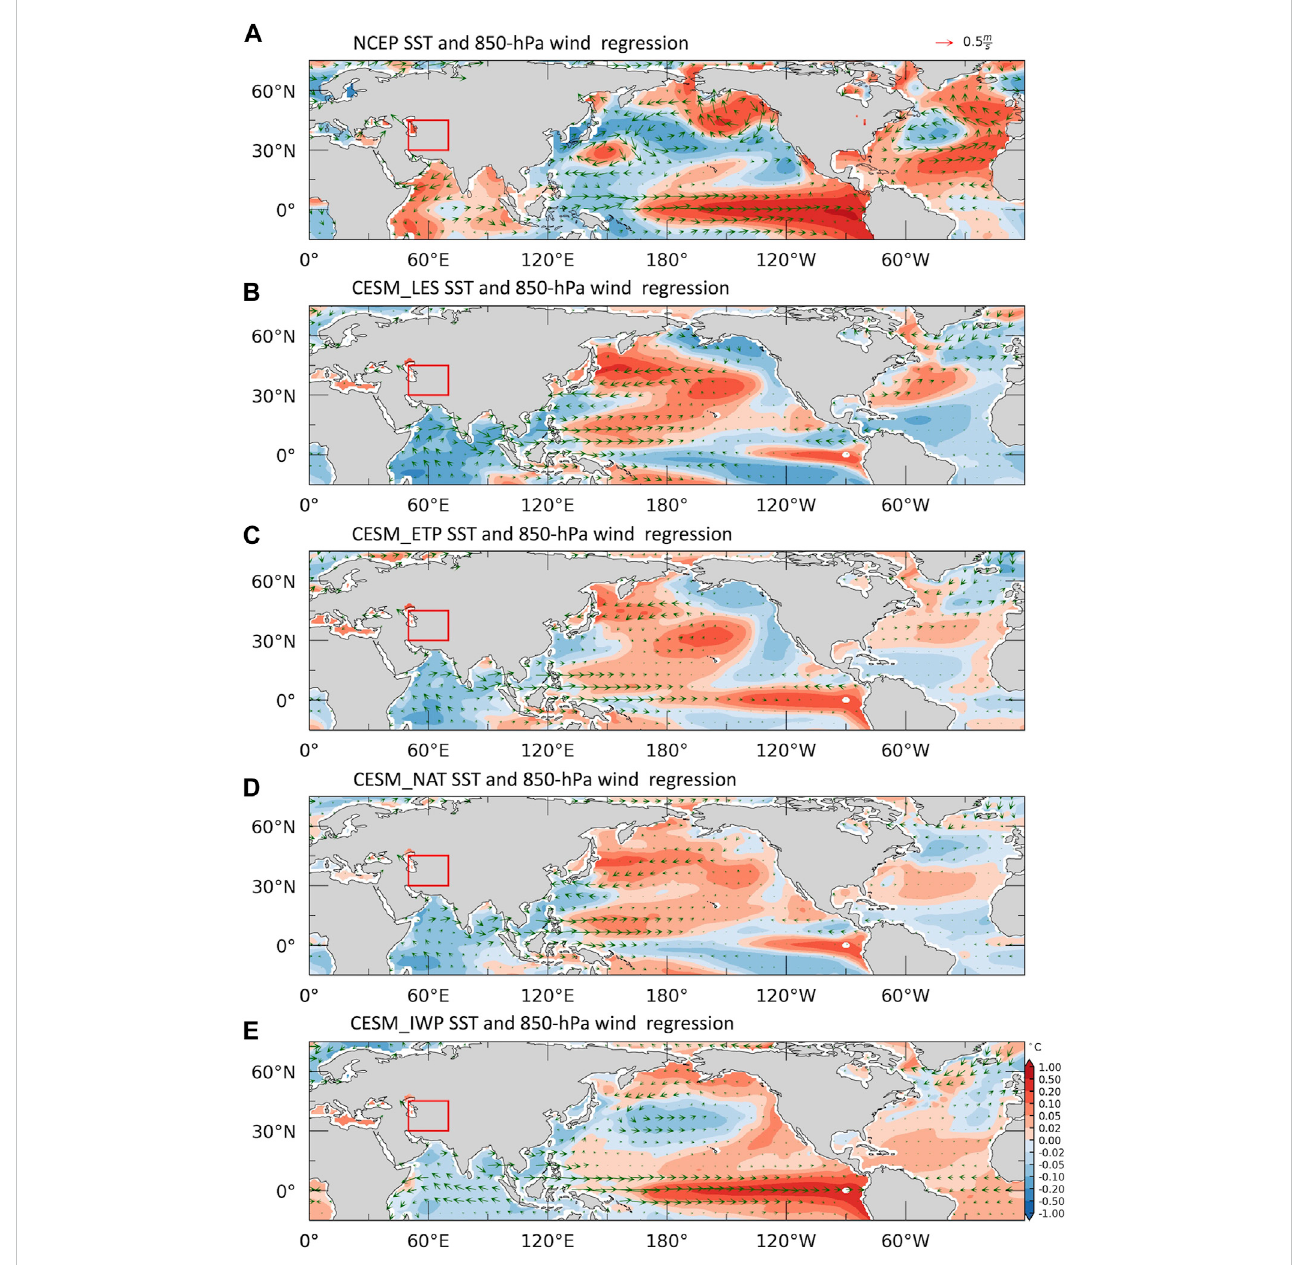
FIGURE 4 Linear regression of summer SST and 850-hPa winds on RWS_CGT index for (A) NCEP, (B) CESM_LES, (C) CESM_ETP, (D) CESM_NAT, and (E) CESM_ IWP. The pacemakers use ensemble mean and the red box is the location of RWS_CGT index.